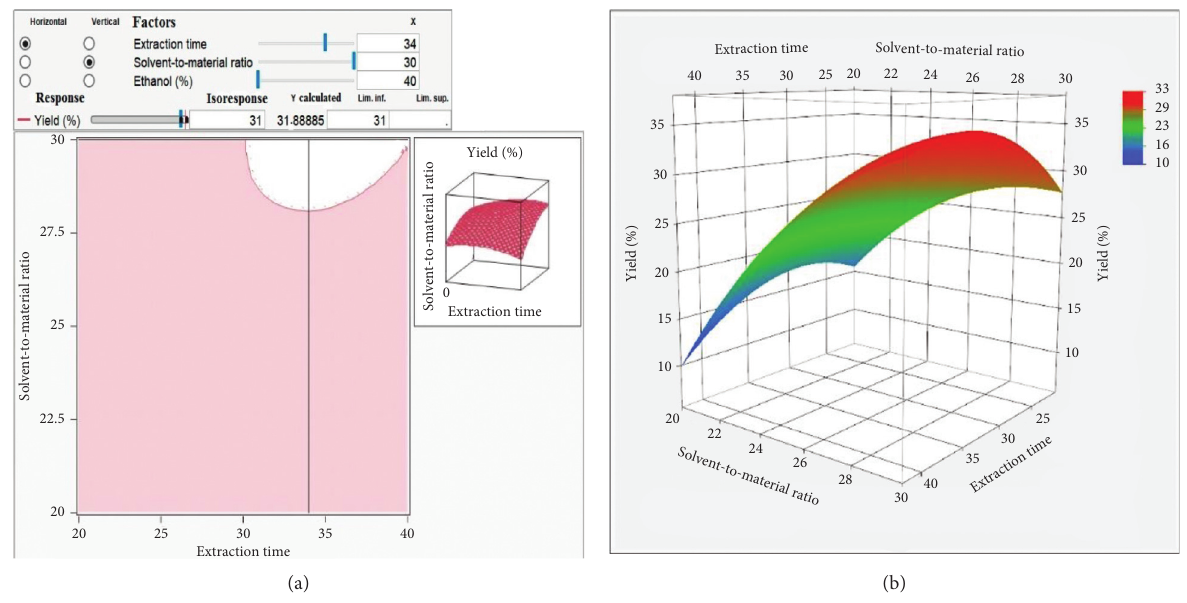
Figure 3: (a) Isoresponse plot showing the optimal compromise zone leading to the desired yield (31%) obtained by fixing the third parameter (ethanol (%)) in its low level (40%) and varying the other two parameters. (b) 3D plot of the response yield (%) in terms of extraction time and liquid/solid ratio effects and by fixing the concentration of ethanol at